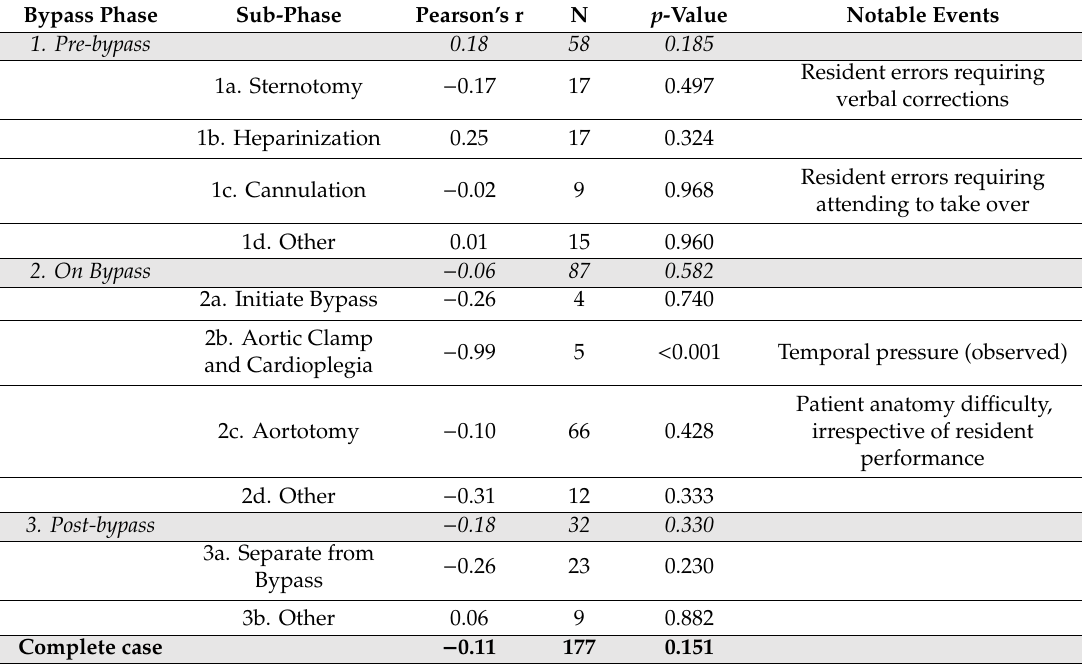
Table 3. Pearson’s r correlations between RMSSD and mean rSO 2 values for bypass phases and sub-phases, with notable events observed within sub-phases where applicable. “Other” refers to time points within the corresponding bypass phases, but occurring outside of pre-specified